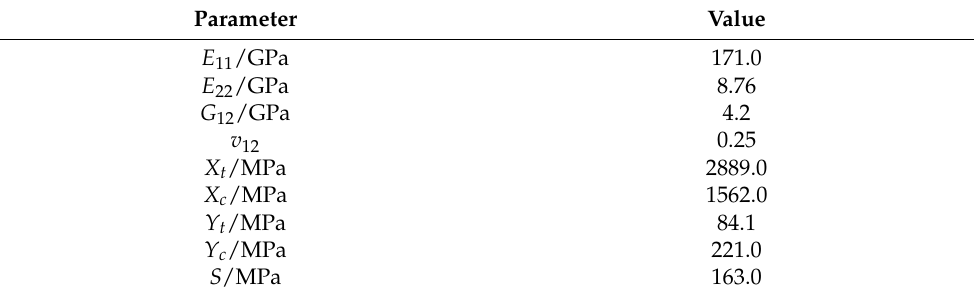
Table 1. Properties of CCF800/AC531 composite ply.